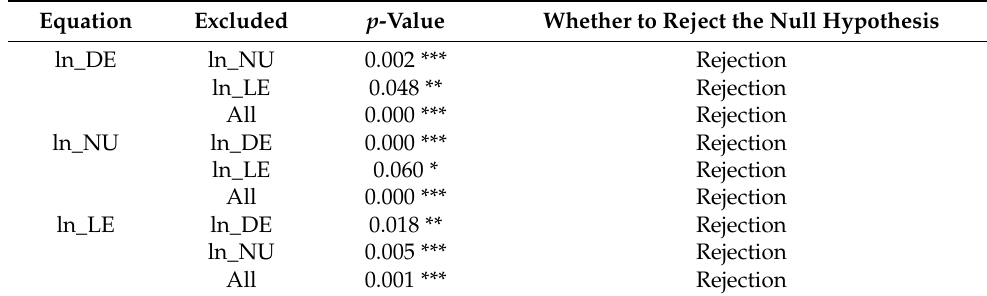
Table 5. Granger causality